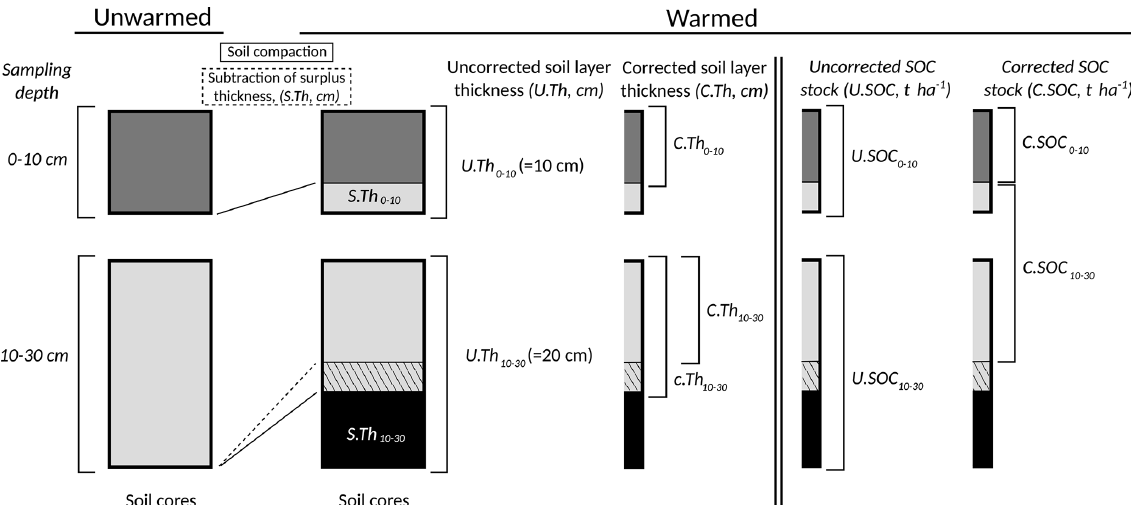
Figure B8. Soil mass correction. Due to significant soil compaction (increasing bulk density (BD)) with increasing soil temperature in the upper soil layers (Fig. B7), a certain soil depth in unwarmed soil corresponds to ever shallower soil depths at warmer soil